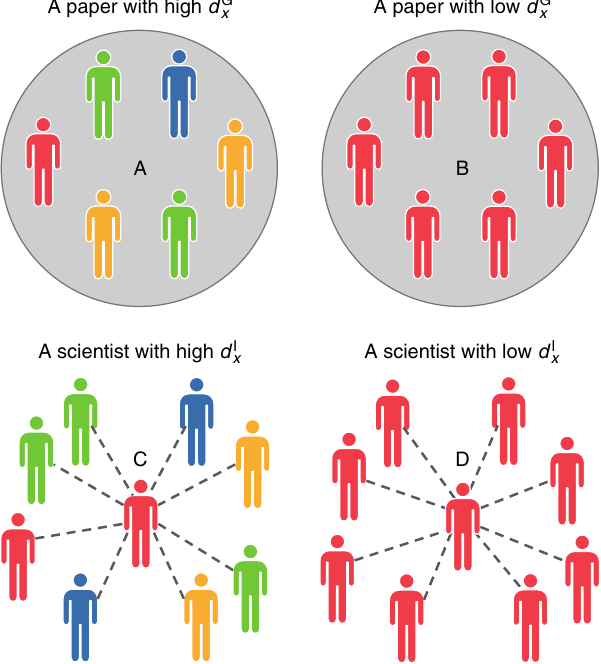
Fig. 2 Group vs. individual diversity. For any given class of diversity, x ∈ {eth, age, gen, dsp, aff}, differences in color represent differences in terms of x . The group diversity index d G of Paper A is higher than that of Paper B. x